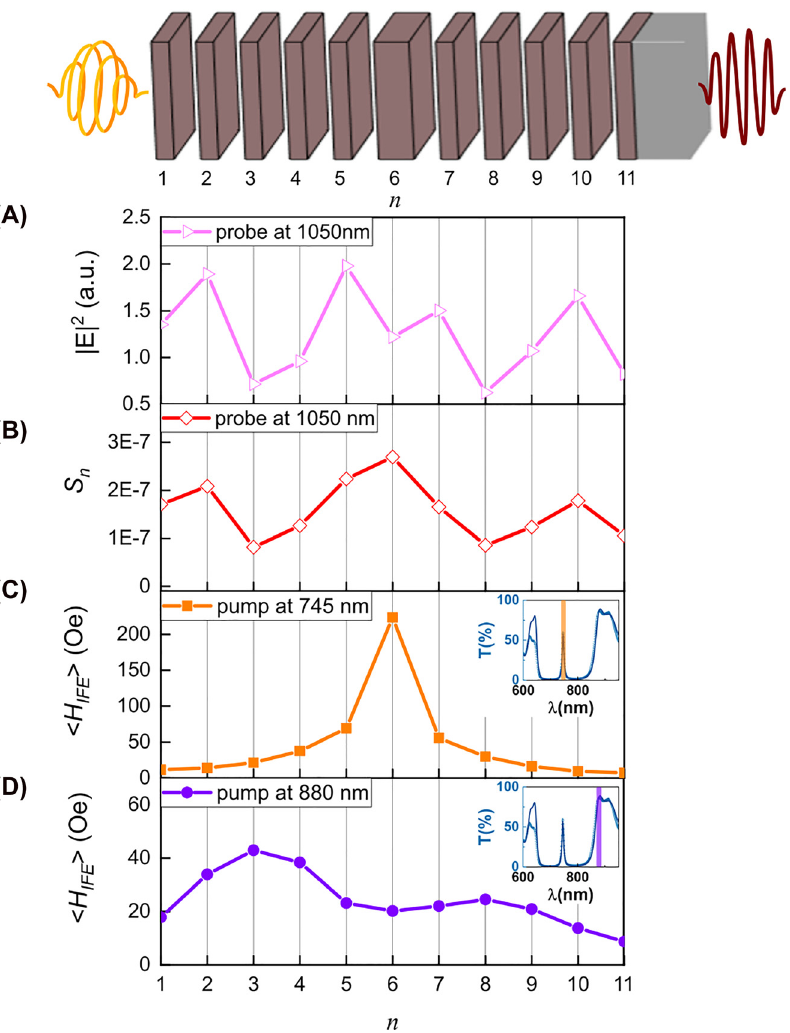
Figure 3: Calculated distribution of the electric field intensity, magneto-optical sensitivity and the averaged effective IFE field on the serial number of the magnetic layer in the